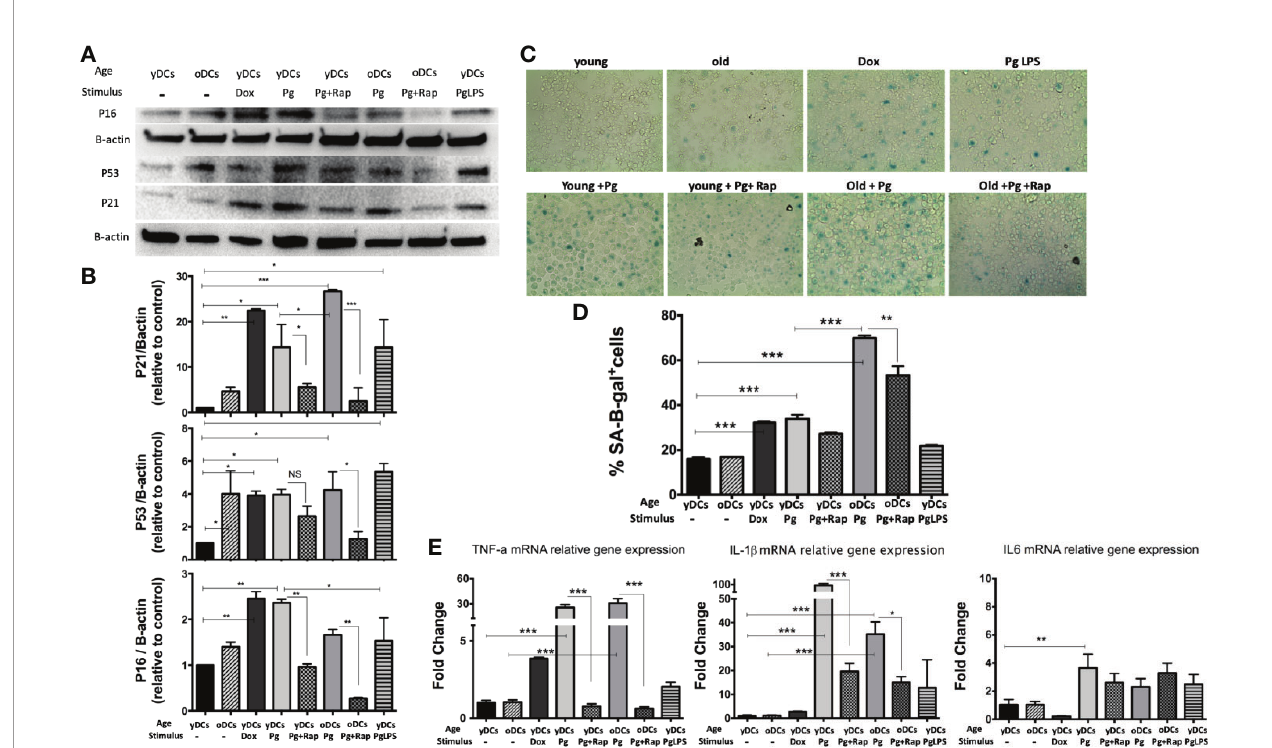
FIGURE 1 | P.gingivalis induces immune senescence in murine bone marrow derived DCs (DCs): At day 6, DCs from young (yDCs) and old (oDCs) mice were co- cultured with P.gingivalis (10 MOI) ± Rapamycin (1µM), yDCs were treated with Dox (50nM) or P.gingivalis LPS (100ng/ml) and CS pro fi ling was performed at day 8. (A) Representative western blot images for p16 INK4A , p53, and p21 Waf1/Clip1 protein expression in BMDCS treated with P.gingivalis ± Rapamycin, Dox or LPS. (B) Densitometric analysis of p16 INK4A , p53, and p21 Waf1/Clip1 protein expression in BMDCs. b -actin was used as a loading control. Band densities were normalized to b -actin, and data presented as fold change relative to the control (yDCs with no stimulus). (C) Representative images of SA- b -gal staining of BMDCs at PH 6, blue stain indicates senescence (D) Quanti fi cation of SA- b -gal positive cells using FACS analysis. (E) qPCR analysis showing relative mRNA expression of TNFa, IL-1 b - and IL6 in BMDCs treated with P.gingivalis ± Rapamycin, Dox or LPS. Relative gene expression was calculated using delta-delta CT method and presented as fold change relative to the control (yDCs.). Analysis was done using one-way ANOVA and Tukey multiple comparison post hoc test (Data are expressed as means ± SD, *p<0.05, **p<0.01, ***p<0.001). NS, not signi fi